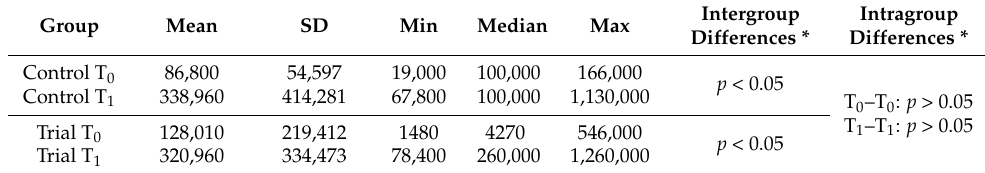
Table 6. Descriptive statistics of the total bacterial count expressed as copies/microlitre.